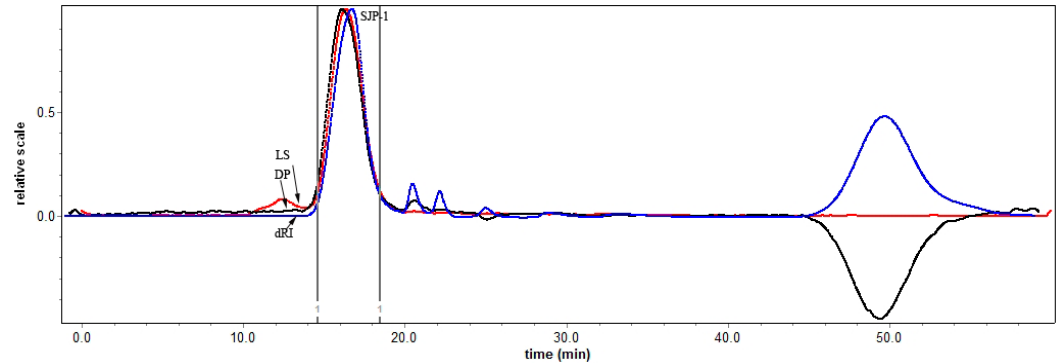
Figure 3. Elution profile of the purified SJP in a SEC-MALLS system.